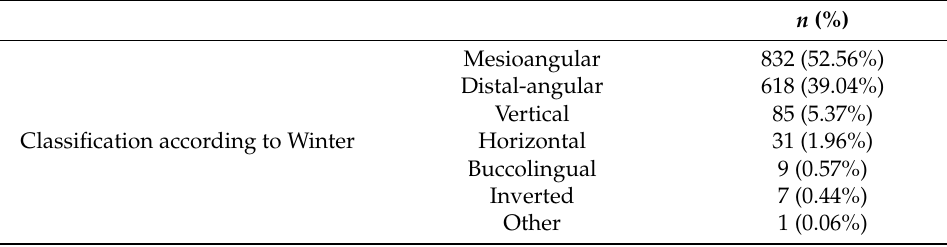
Table 3. Frequency of impaction degrees among impacted mandibular third molars according to Winter in the study